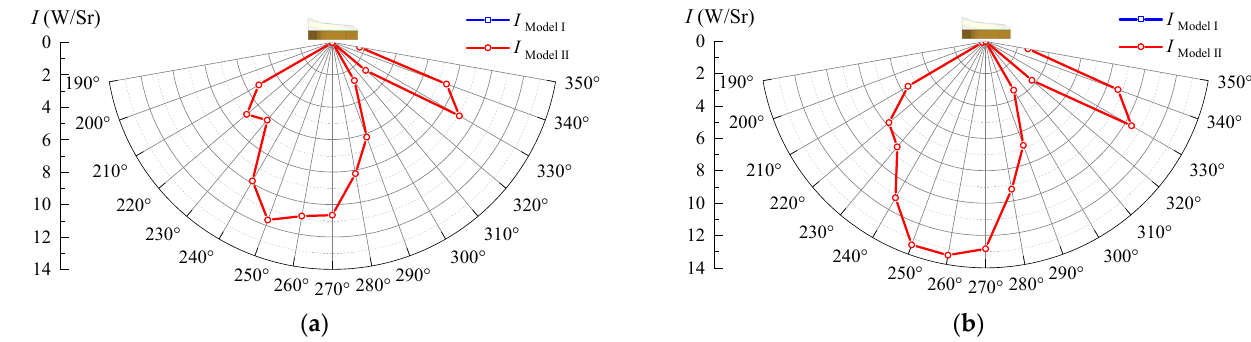
Figure 27. Infrared radiation intensity of de fl ectors. ( a ) 3–5 µm band; and ( b ) 8–14 µm band.